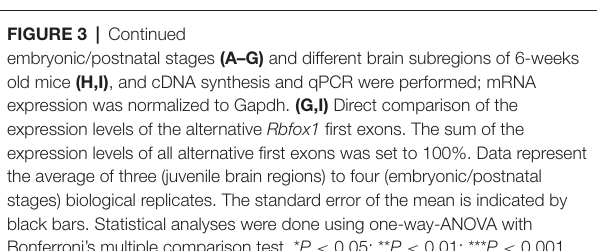
FIGURE 3 | Continued embryonic/postnatal stages (A–G) and different brain subregions of 6-weeks old mice (H,I) , and cDNA synthesis and qPCR were performed; mRNA expression was normalized to Gapdh. (G,I) Direct comparison of the expression levels of the alternative Rbfox1 first exons. The sum of the expression levels of all alternative first exons was set to 100%. Data represent the average of three (juvenile brain regions) to four (embryonic/postnatal stages) biological replicates. The standard error of the mean is indicated by black bars. Statistical analyses were done using one-way-ANOVA with Bonferroni’s multiple comparison test. * P < 0.05; ** P < 0.01; *** P < 0.001.